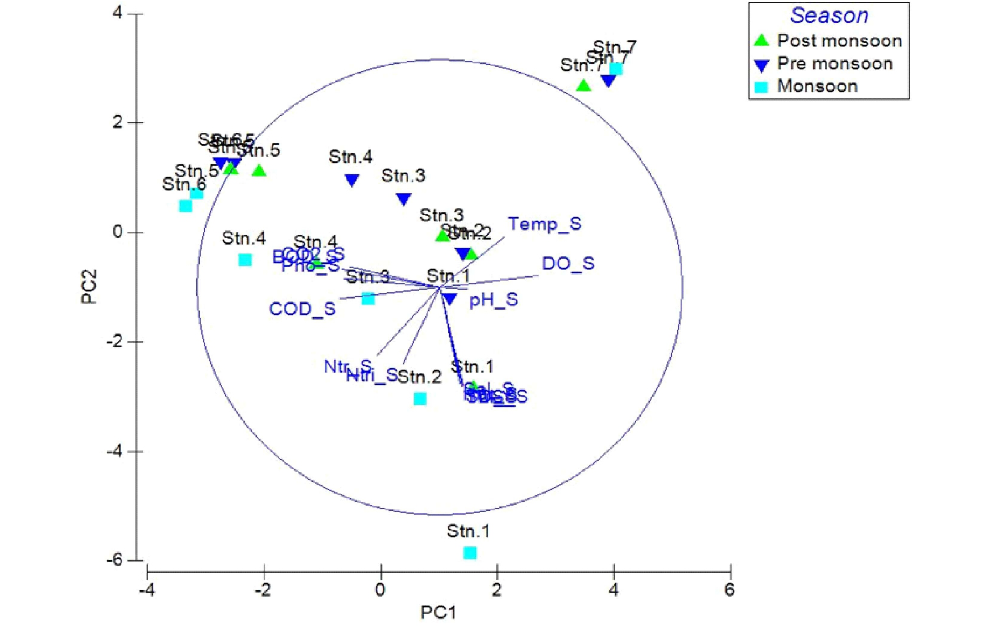
Fig. 4: PCA plot of water quality parameters of Veli-Akkulam and Vellayani